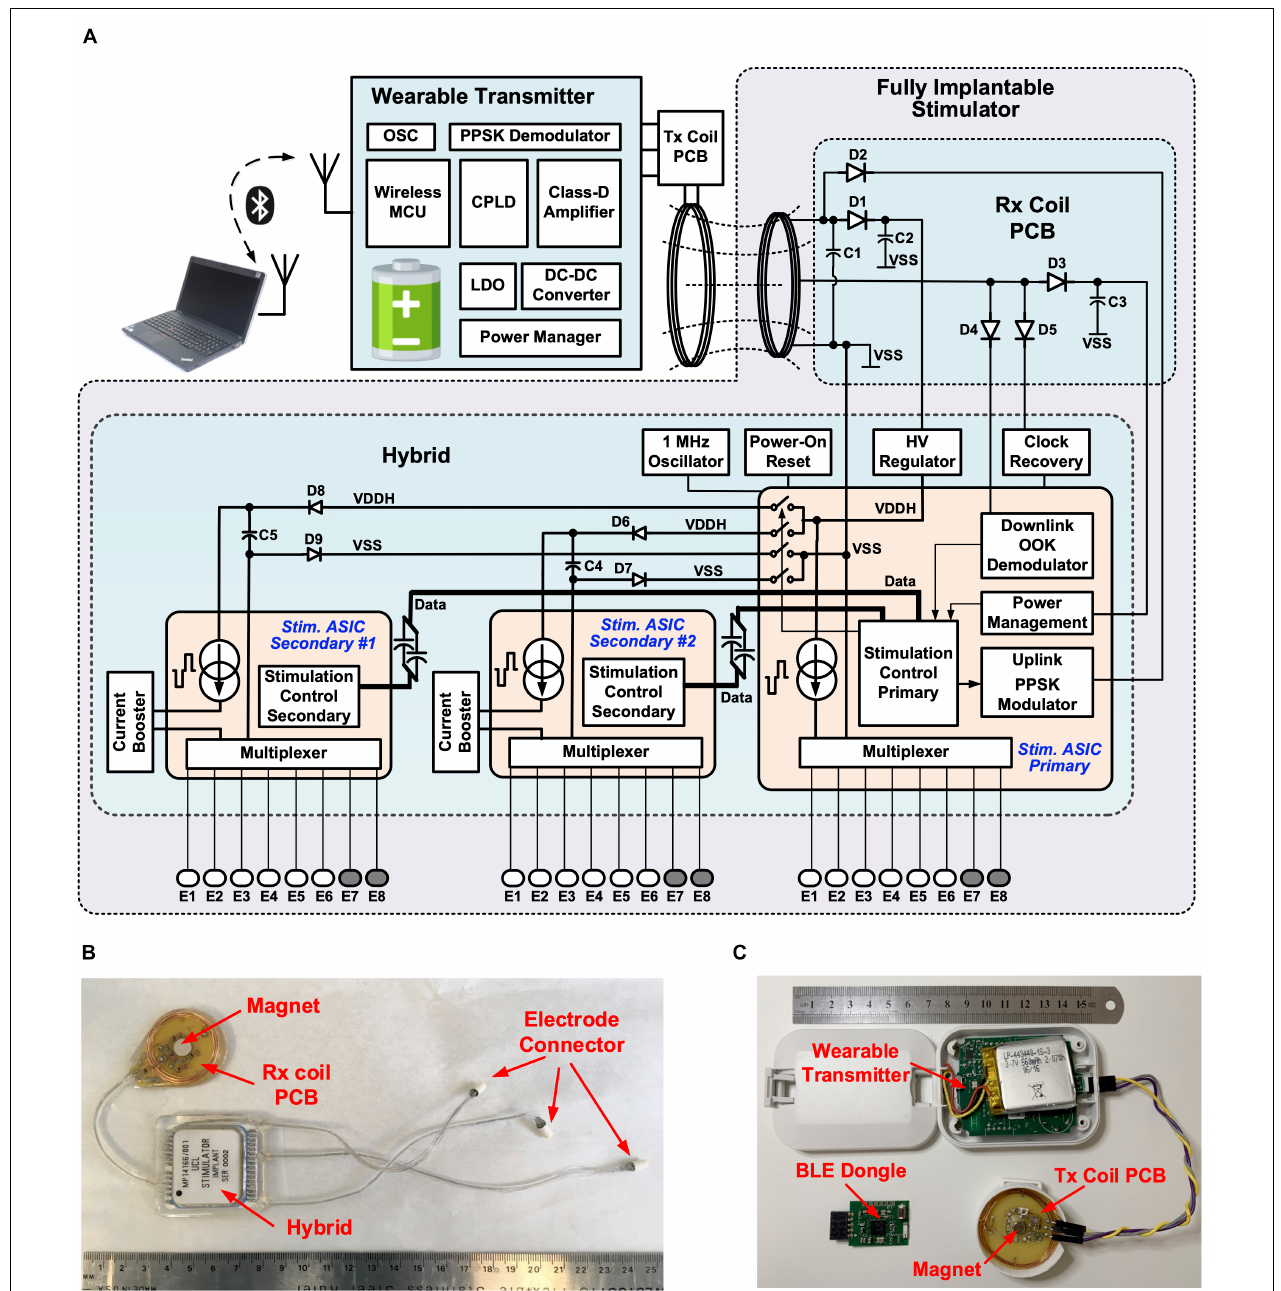
FIGURE 1 | Wireless, fully implantable multi-channel stimulator: (A) System architecture; (B) Implantable stimulator; (C) Wearable transmitter and BLE